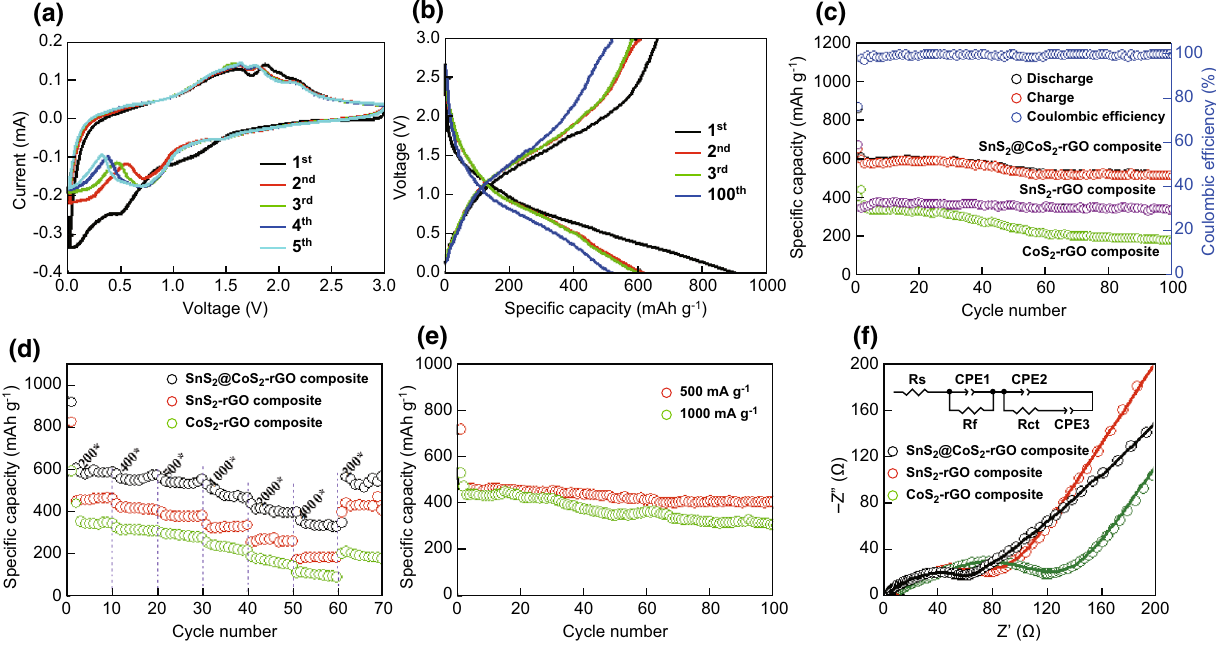
Fig. 6 a CV curves of the SnS 2 @CoS 2 –rGO composite, b charge/discharge profiles for the initial three cycles and the 100th cycle of the